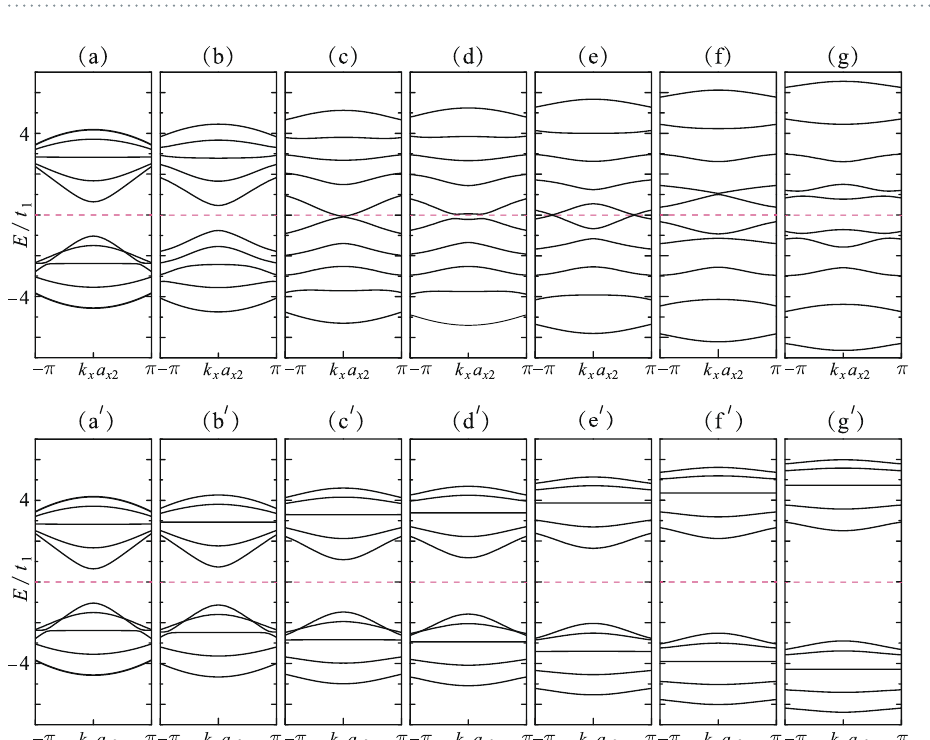
Figure 12. ( a – g ) Dispersion relations of 5a-Q1D-PNR as functions of the electric field E y . The relating electronic potential are respectively set for eE a 4 sin 0 Dispersion relations as functions of E z by setting the electronic potential eE z a 1 cos β = 0 1.5 t 1 , 2.6 t 1 , 4.0 t 1 , 5.6 t 1 , 7.0 t 1 and 8.0 t 1 ,